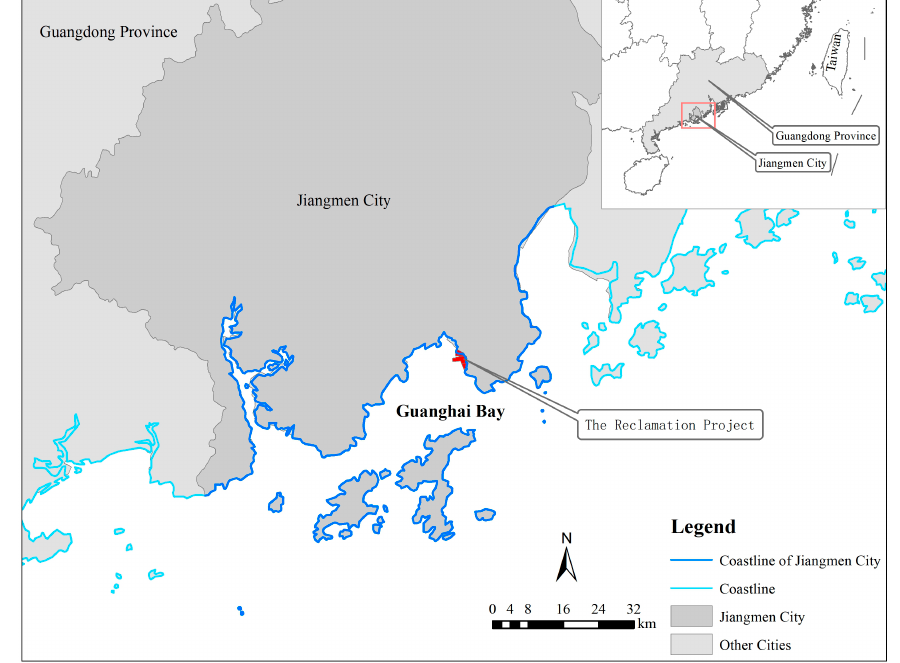
Figure 1. Location of Guanghai Bay in Guangdong Province, China.